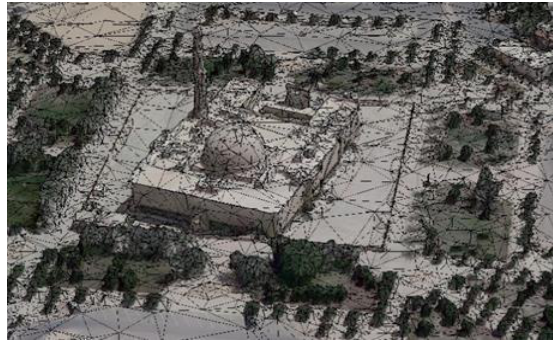
Figure 5. Wireframe from 10cm Aerial Imagery.